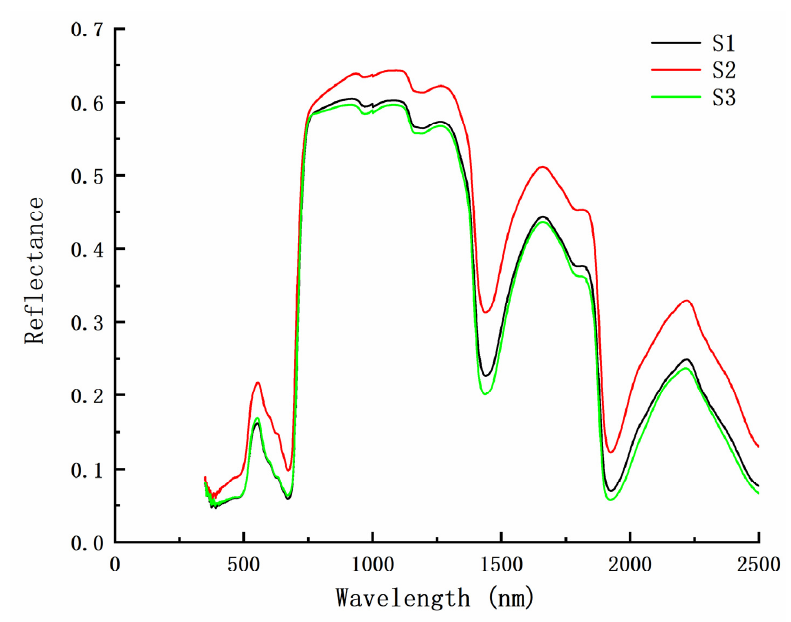
Figure 4. Spectral reflectance curves of peanuts of different plant densities under single seeding conditions.